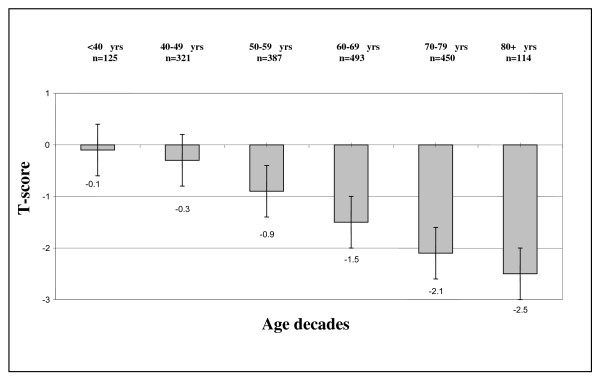
Mean QUS T-score in various age decades. This figure depicts a categorization of QUS T-score values and number of participants in our study population according to age-decade only. No significant decline in T-score was seen in women (premenopausal and postmenopausal) below 50 years. This parameter exhibits a fall pattern especially after the 5th decade as seen in the figure (p = 0.01).